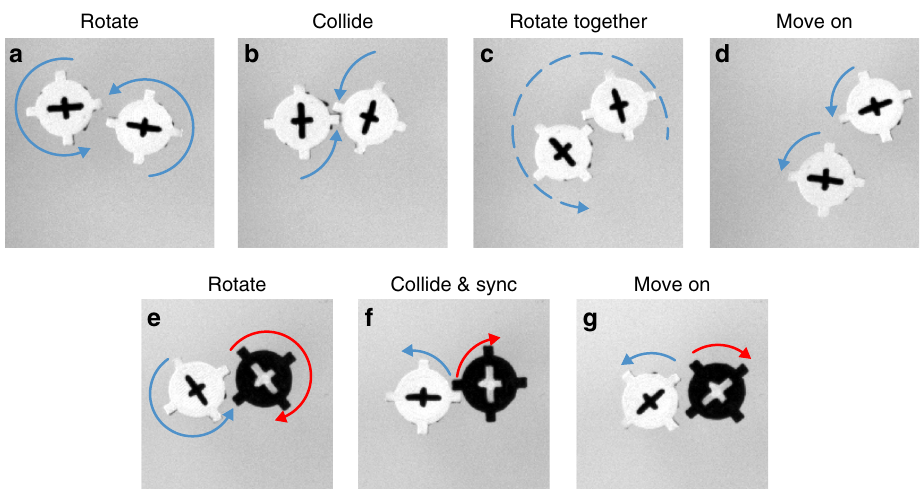
Fig. 3 Typical collision between equal and opposite rotors. Collision sequence for likewise spinning rotors is a individual rotation, b collision, c collective rotation and d individual motion (duration between frames is 0.12 s). When e opposite rotors collide, we observe f synchronization followed again by g individual motion (duration between frames is 0.07 s). Due to the additional collective rotation likewise spinning rotors spend more time together, which